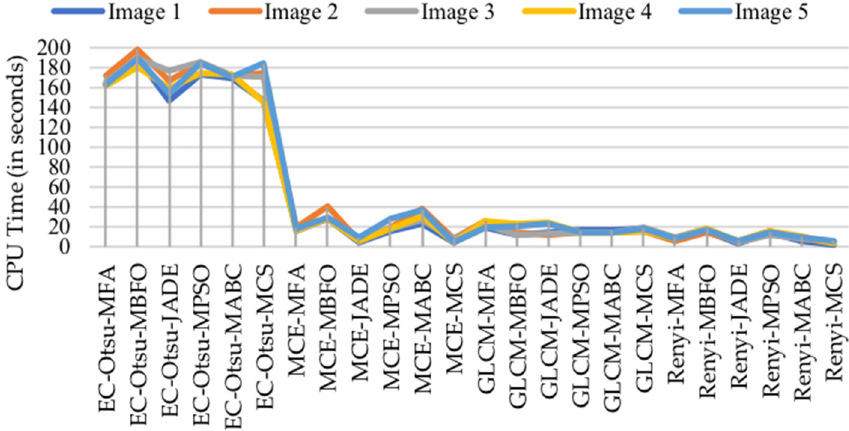
Figure 18. Results of CPU time for all algorithms at level 8 segmentation.